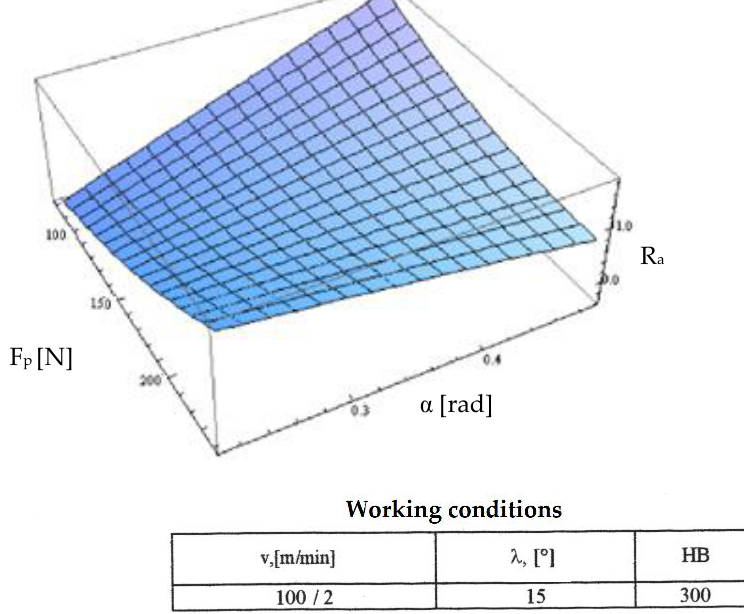
Figure 19. Influence of the clearance angle and radial force on roughness R a.